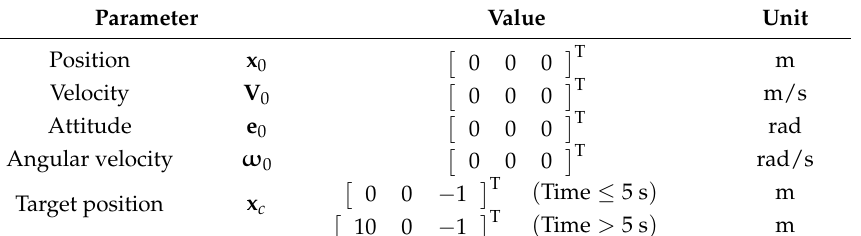
Table 6. Initial condition and target values in experiment.